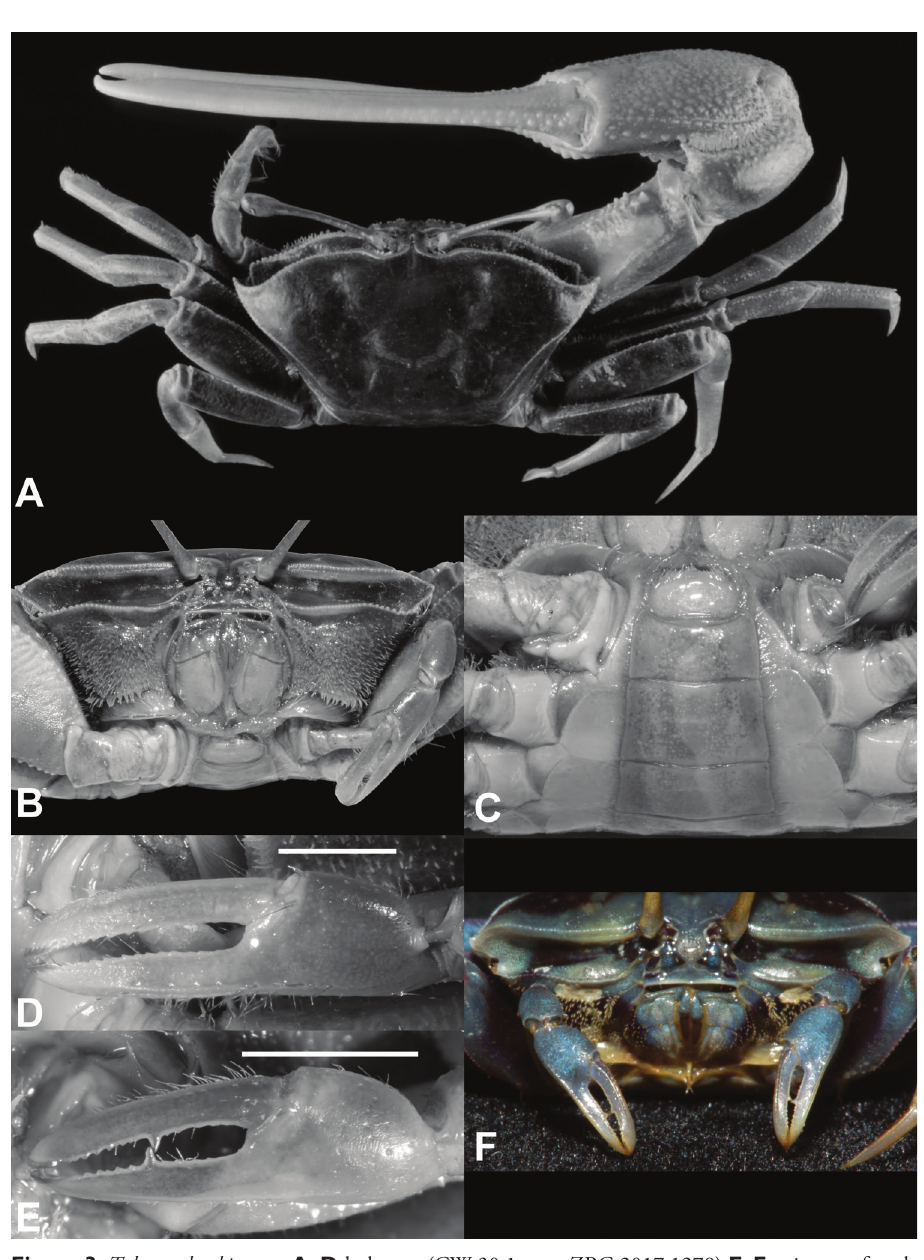
Figure 3. Tubuca alcocki sp. n. A–D holotype (CW 30.1 mm, ZRC 2017.1278) E, F ovigerous female (CW 19.8 mm, NCHUZOOL 14897; Thailand). A dorsal view B frontal view C pleon and telson D, E left minor cheliped F frontal view, with living colouration. Scale bars: 5.0